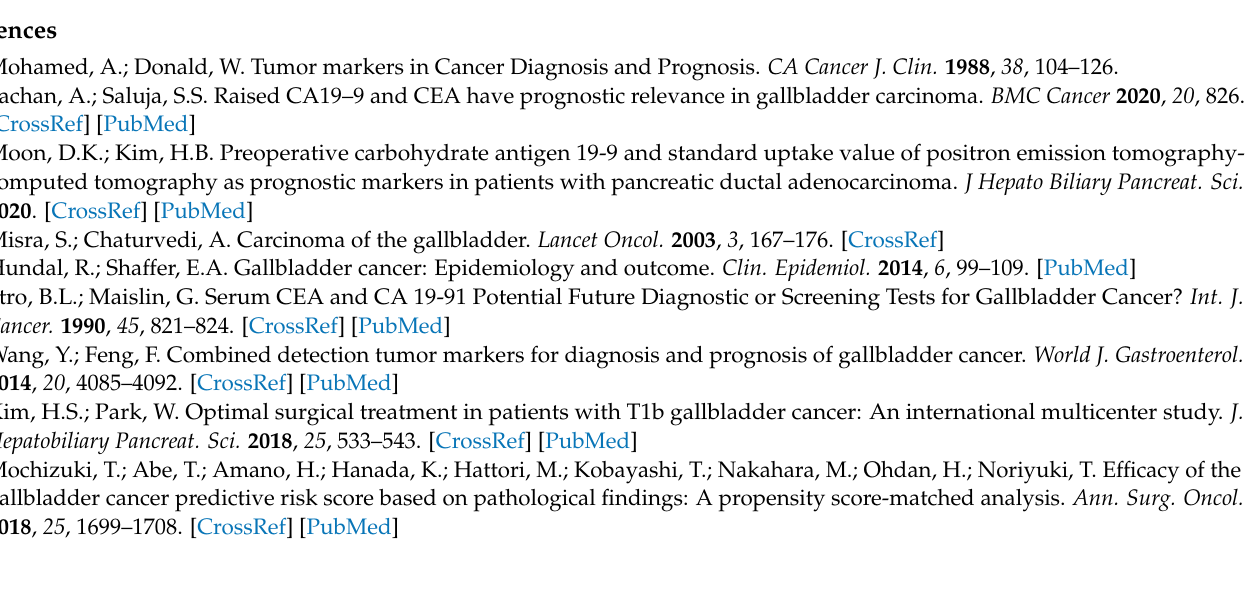
Figure S2: Distribution of preoperative CA 19-9, log CA 19-9 level according to